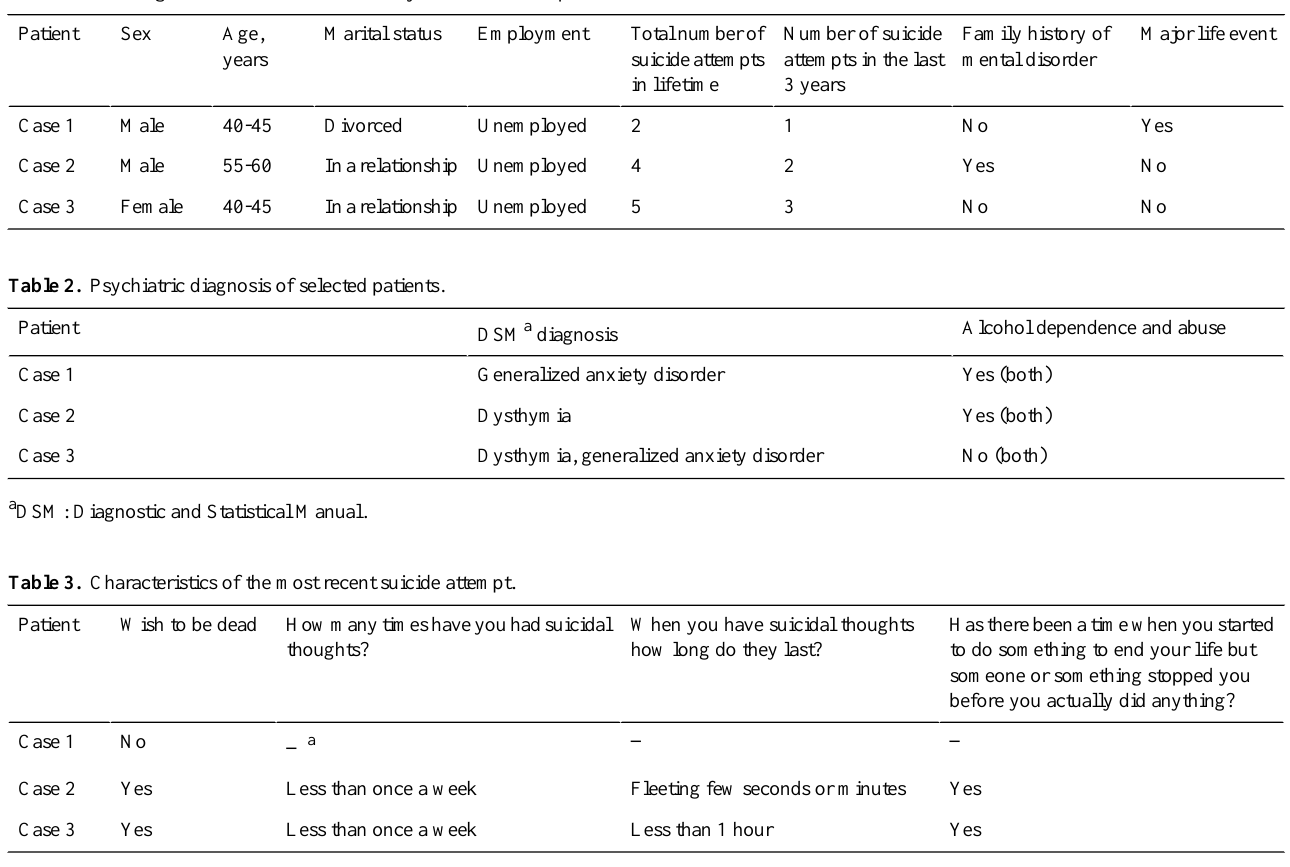
Table 1. Sociological main features and history of suicide attempt.